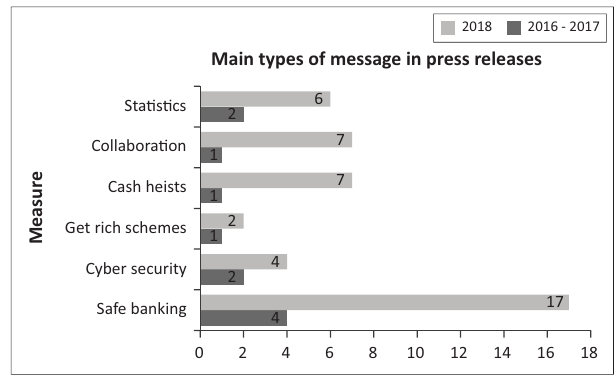
FIGURE 4: Types of messages on the website of South African Banking Risk Information Centre during each time